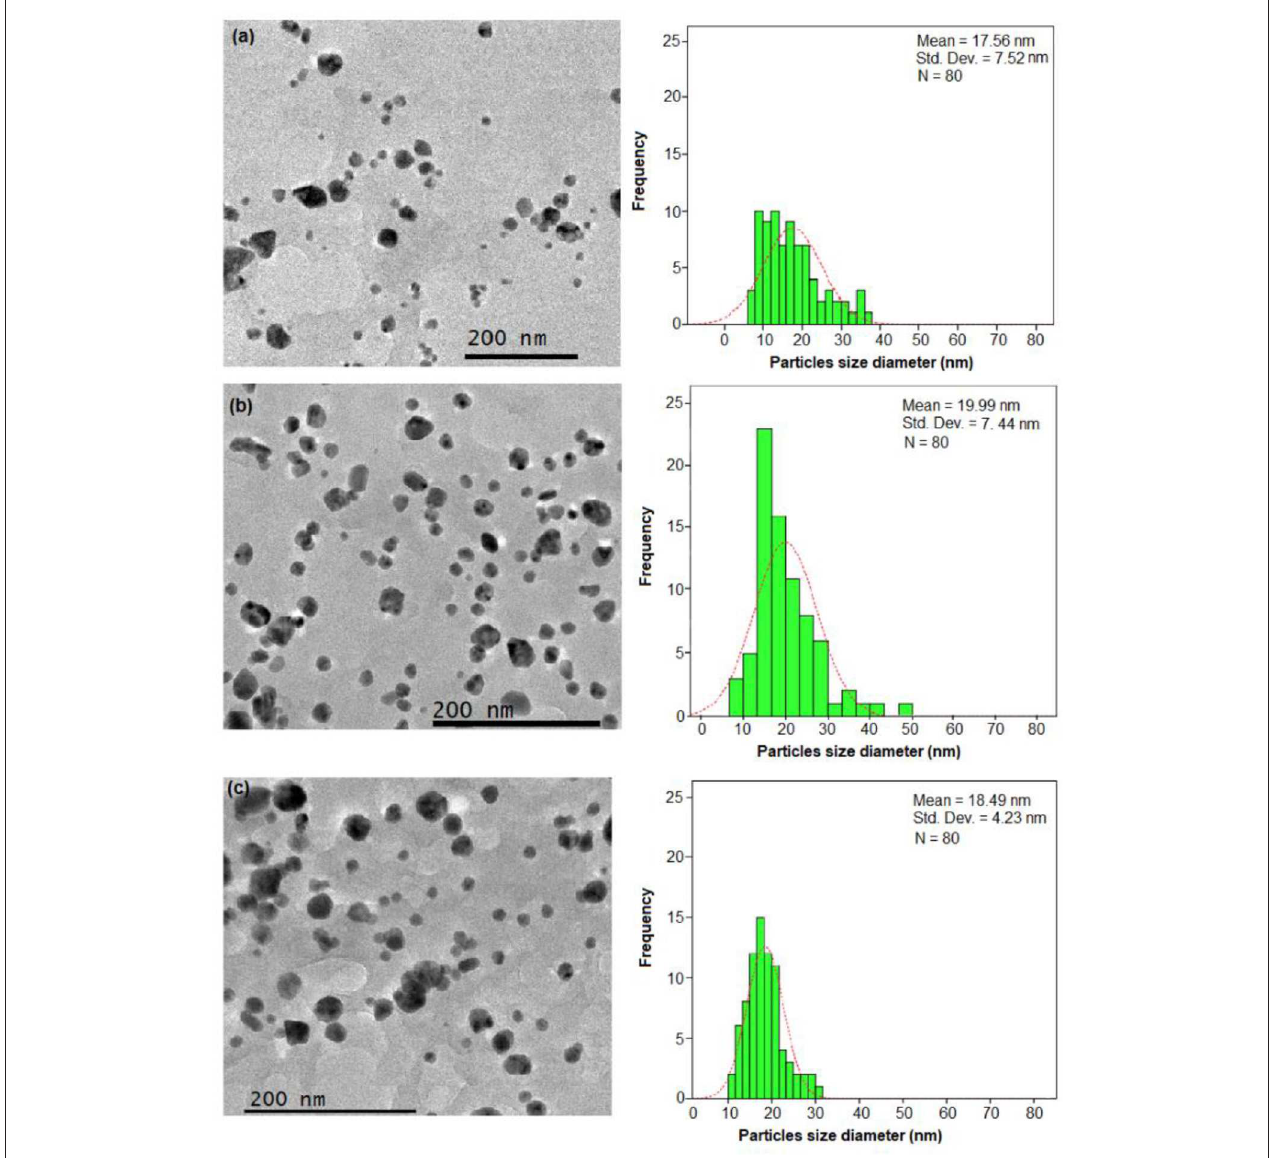
FIGURE 4 | The FETEM images and histogram of the particle size distribution of E. spiralis /Ag-NPs at (a) 0.010M of AgNO 3 and (b) 0.100M of AgNO 3 and (c) at its best parameter condition, at 600min of stirring reaction